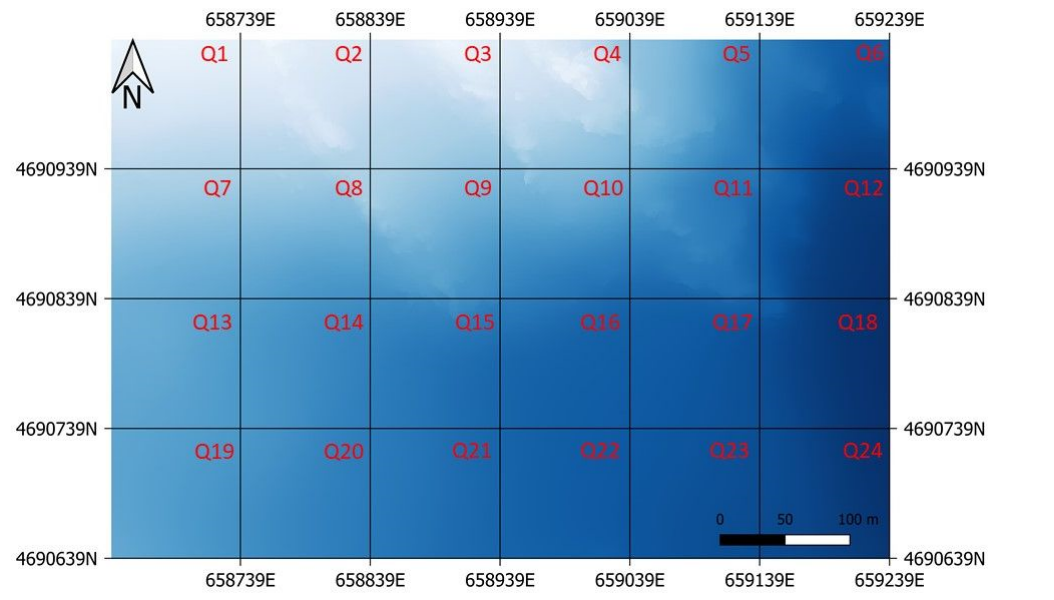
Figure 3. Representation of the entire subset subdivision in 24 squares, or sectors, of 100 m × 100 m. Among the 24 squares generated at the beginning, only six (Q2, Q3, Q4, Q8, Q15, Q23) were selected as representative of the different investigated seabed morphologies. These (MVI) described in Section 2.2.